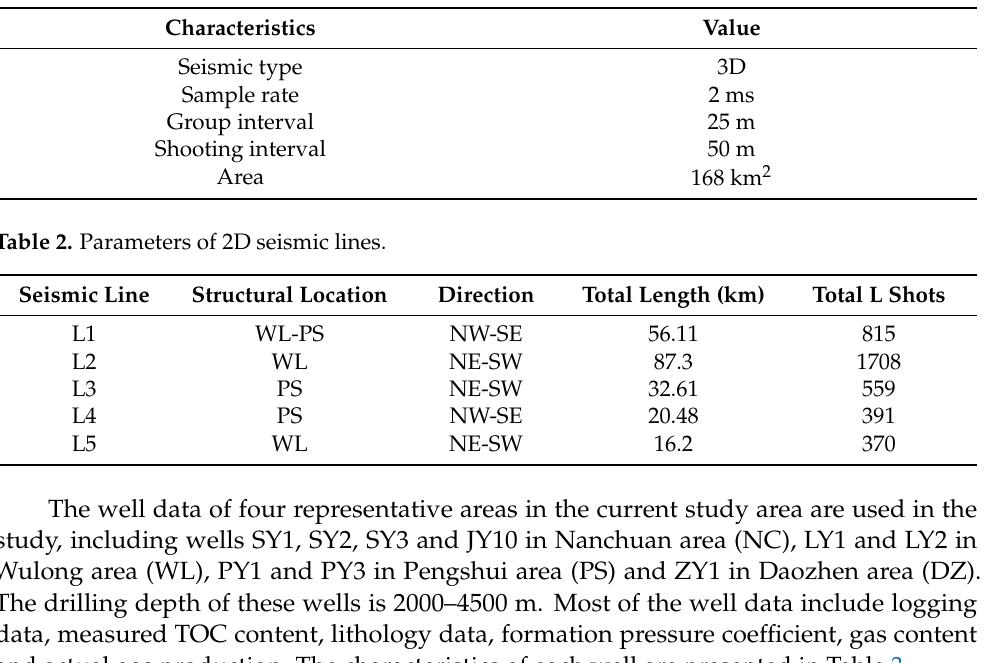
Table 1. Parameters of the 3D seismic grid.